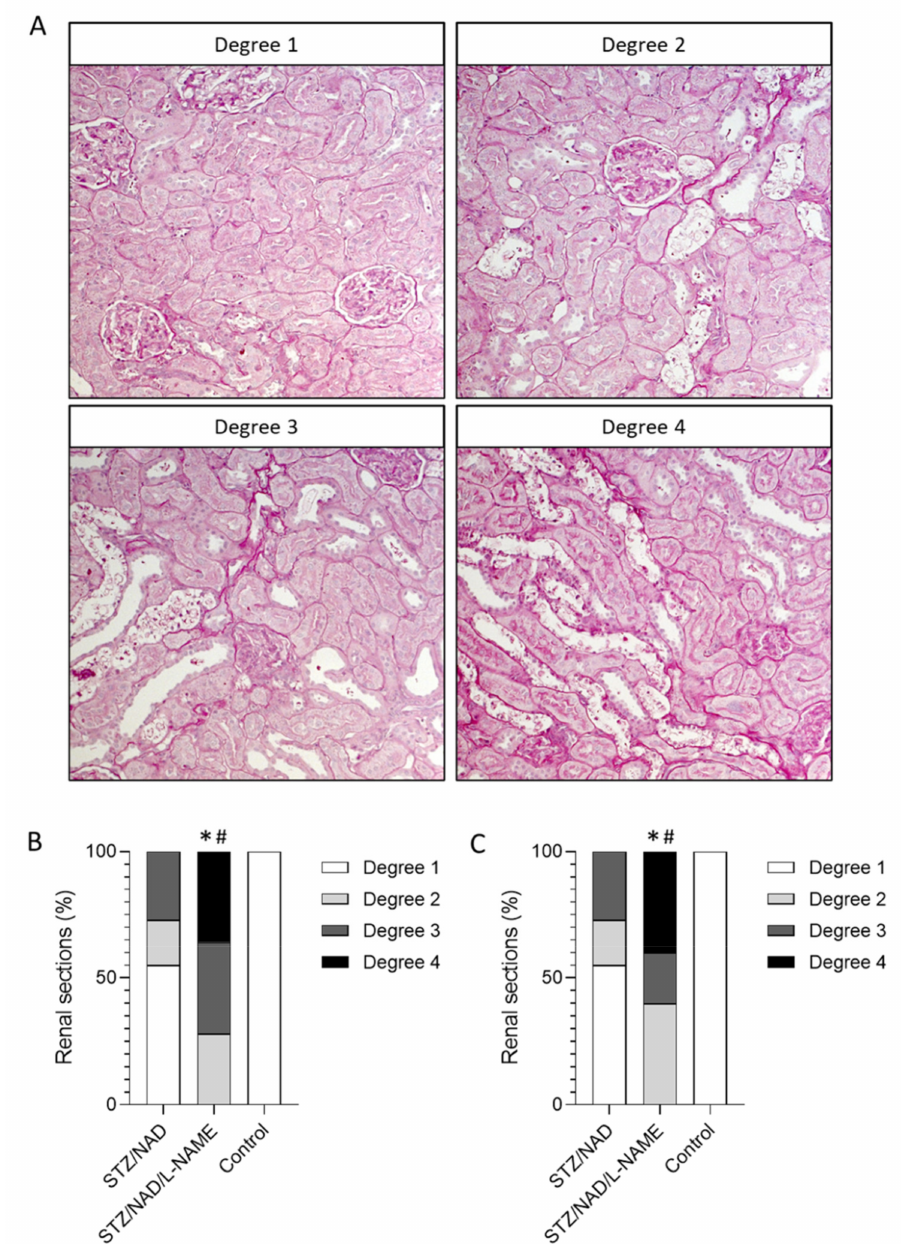
Figure 6. Semi-quantitative grading of renal interstitial histopathology according to 4 different degrees of severity ( A ). PAS-stained renal sections of STZ/NAD, STZ/NAD/-L-NAME diabetic rats and non-diabetic control rats were analyzed blinded by a researcher at week 9 ( B ) and week 12 ( C ) and divided into the following categories: Degree 1: normal interstitium; degree 2: >70 % normal interstitium; degree 3: >50% normal interstitium; degree 4: <50% normal interstitium. Chi-square analysis was performed. * p < 0.05 vs. STZ/NAD, # p < 0.05 vs.